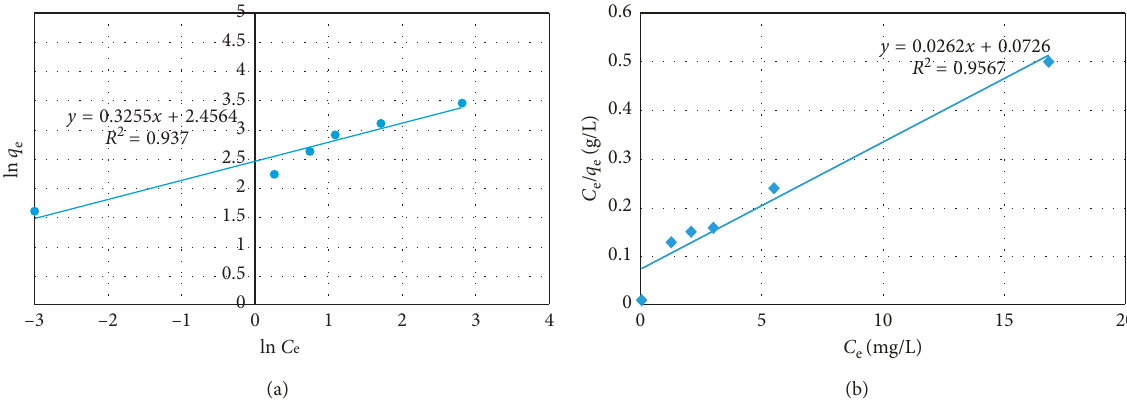
Figure 15: Sorption isotherms: (a) Freundlich adsorption and (b) Langmuir adsorption of 10mg · L − 1 EBT dye by 0.1g/50 mL NSG nanocomposite at a pH of 3. Table 4: Isothermal parameters for the adsorption of 10 mg · L − 1 EBT dye by 0.1g/50 mL NSG nanocomposite at a pH of 3. Isotherm Langmuir Freundlich D-R